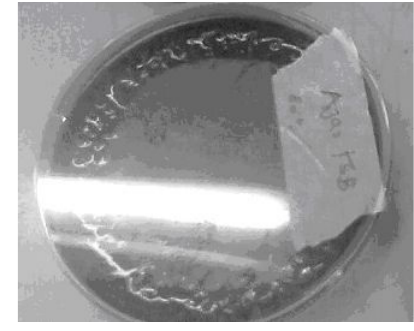
Fig. 1. Clearance zone around a fungal colony after staining Screening for cellulase